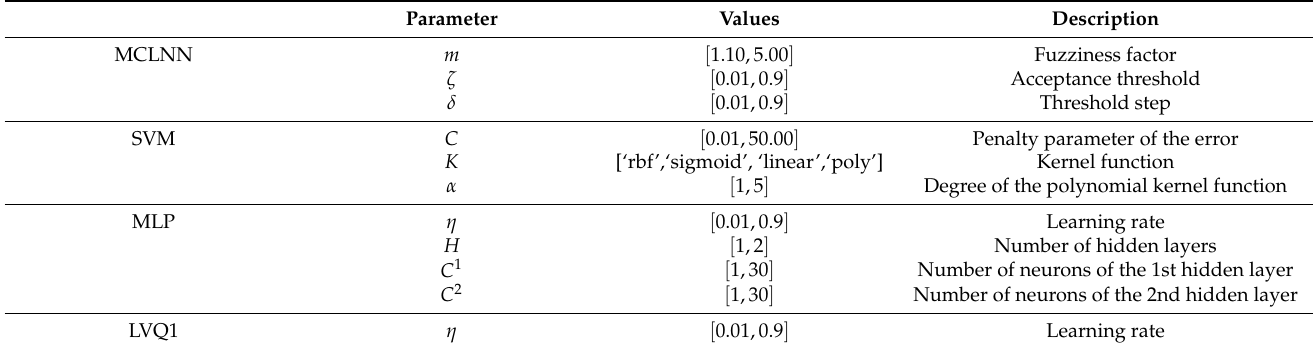
Table 6. Numerical values of algorithmic parameters for the four compared methods.